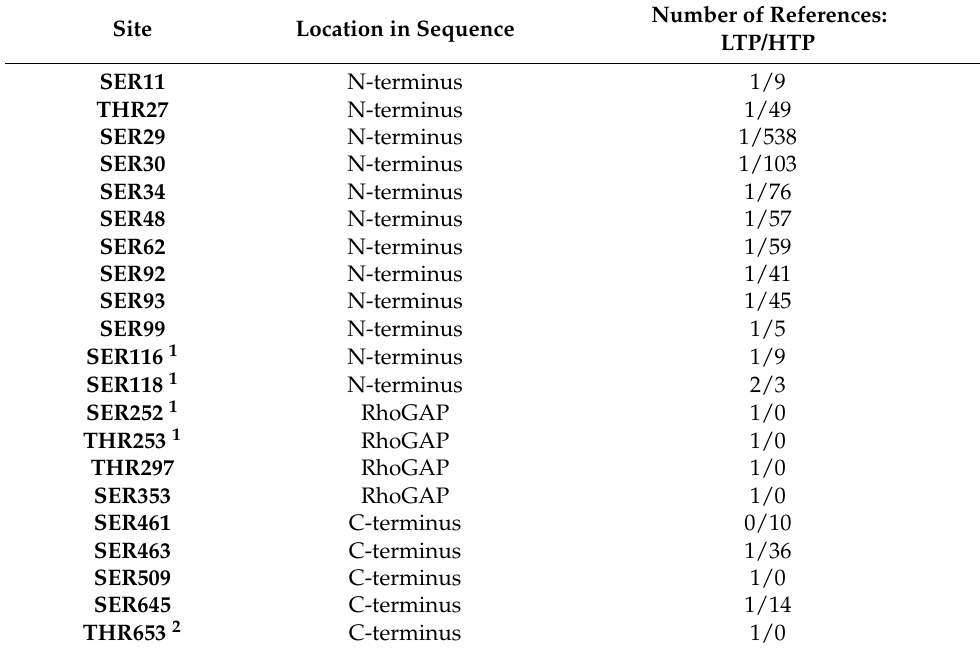
Table 1. Phosphorylation sites in RLIP76. High-throughput studies with five or more references on PhosphoSite and those that were found through RLIP76 specific studies (LTP) are shown. Number of Site Location in Sequence